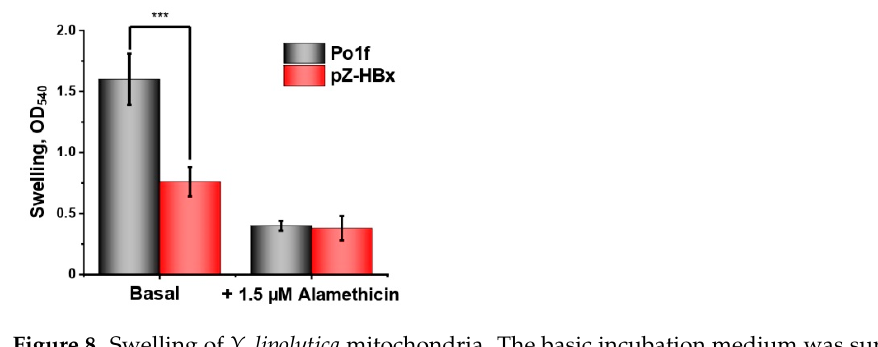
Figure 8. Swelling of Y. lipolytica mitochondria. The basic incubation medium was supplemented with 40 mM KCl and mitochondria (0.2 mg protein/mL). The statistical analyses were carried out by the one-way ANOVA test. ***: p < 0.001.